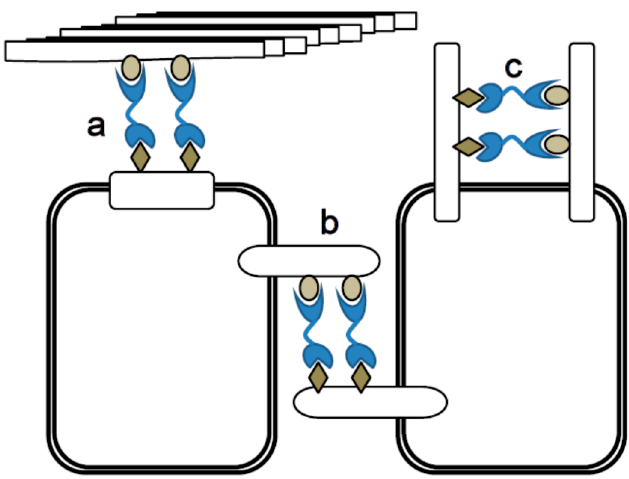
Figure 3. Galectin-9 functions by its divalent sugar binding activity. ( a ) Cell to extracellular matrix adhesion; ( b ) Cell to cell adhesion; and ( c ) Clustering cell surface molecules and modulate their signal delivery.